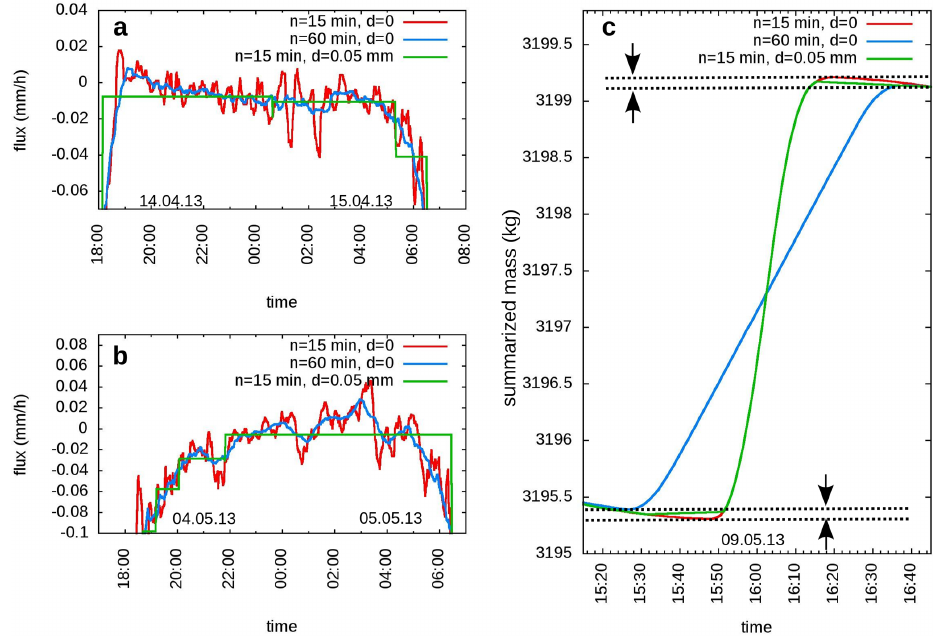
Figure 4. Effects of different averaging time windows n and the oscillation threshold d on the data oscillations (noise error) during nighttime situations (a, b) and the underestimation of precipitation due to the mixing of ET and P (mixing error) during a precipitation event (c) . While (a) and (b) show the calculated fluxes, (c) shows the summarized mass of lysimeter and seepage water representing the cumulative flux at the upper boundary. The underestimation of the precipitation-induced mass change in (c) due to the 60min smoothing is indicated in the figure.